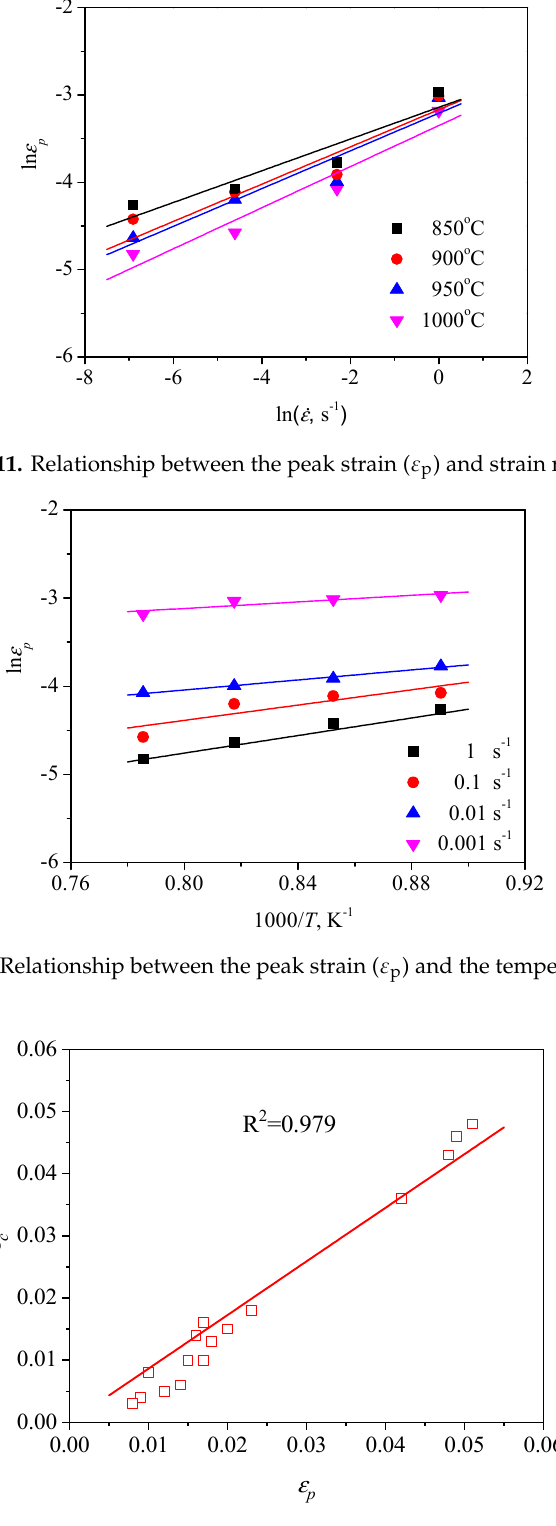
ε ε ) and peak strain ( p ).